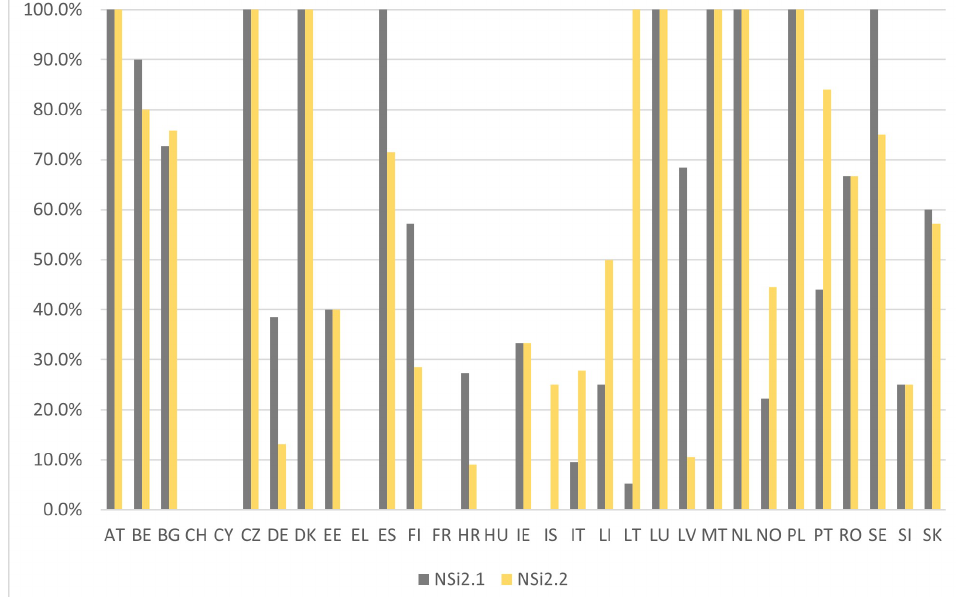
Figure 11. Indicators NSi2.1 and NSi2.2 for